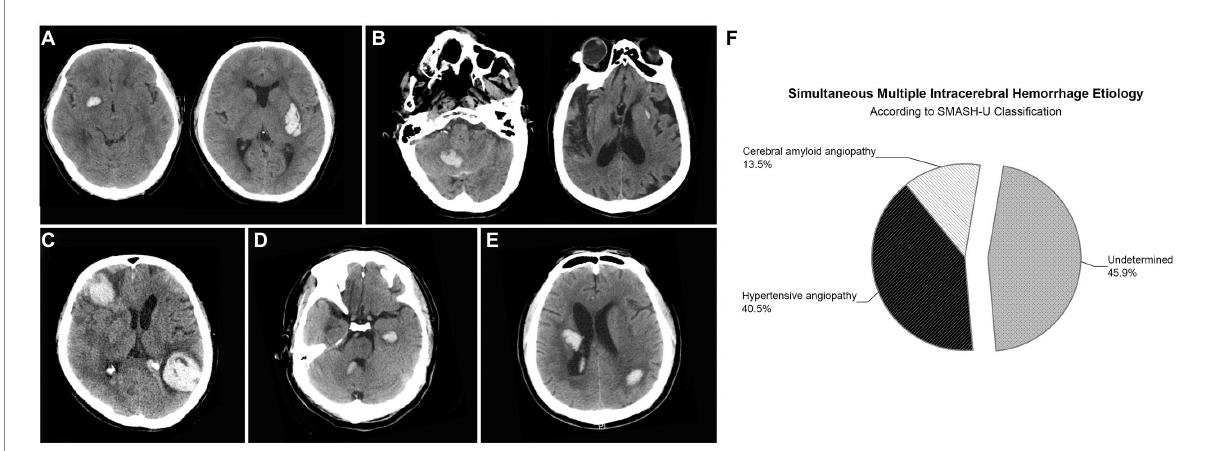
FIGURE 2 Representative examples of patients with simultaneous multiple intracerebral hemorrhage (SMICH). According to SMASH-U classification, patients who had ICH restricted to deep (A) or infratentorial (B) regions with pre-ICH hypertension were classified as hypertensive angiopathy; Cerebral amyloid angiopathy (CAA) was defined by patients aged ≥ 55 with lobar hematoma (C) . Patients with co-existing lobar and deep/infratentorial ICH were classified as undetermined-SMICH (D,E) . Cerebral amyloid angiopathy ( n = 5 [13.5%]) and hypertension ( n = 15 [40.5%]) were common classifications, whereas 17 (45.9%) patients with primary SMICH had an undetermined etiology (F)